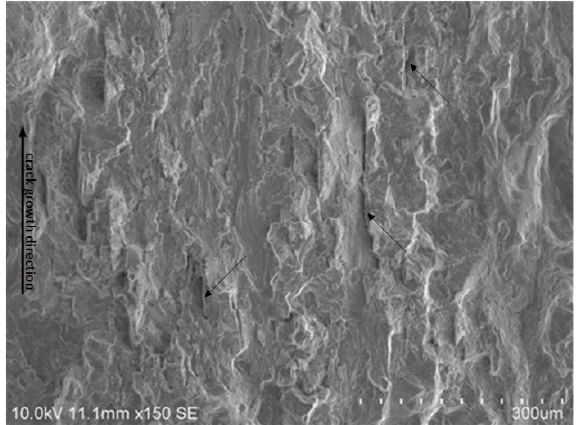
Figure 12. Representative fatigue fracture surface of the broken specimen tested under mode I condition (R = 0.05)—initial fatigue crack growth phase. Table 4. Values of da/dN- ∆ K , ∆ K eff curves parameters— C , m under R = 0.05 and 0.5